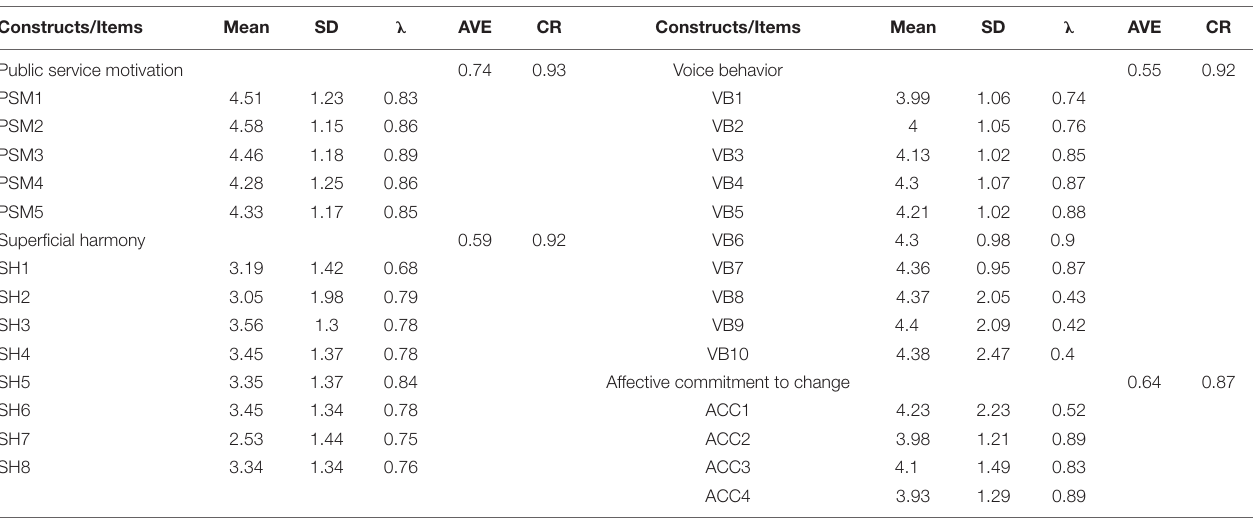
TABLE 2 | Standardized factor loading of confirmatory factor analysis for the CFA sample.